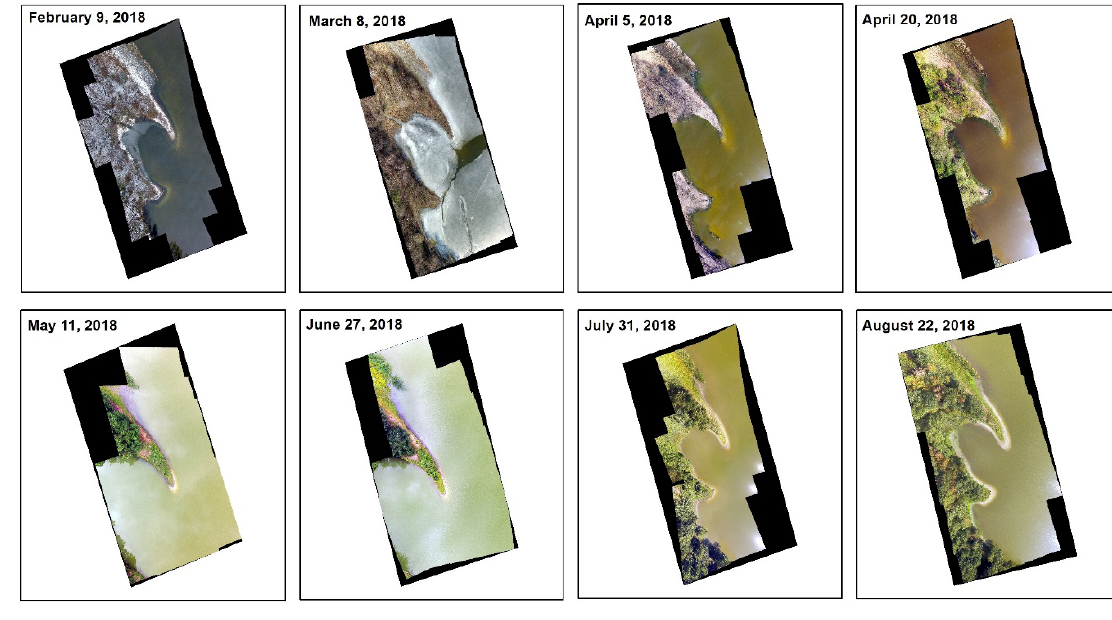
Figure 4. Mosaic images of monitored time horizons